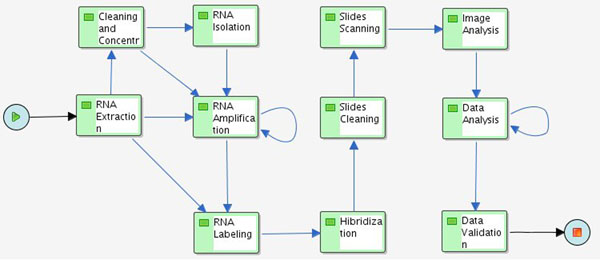
MicroarrayWorkflow as defined in SIGLa.